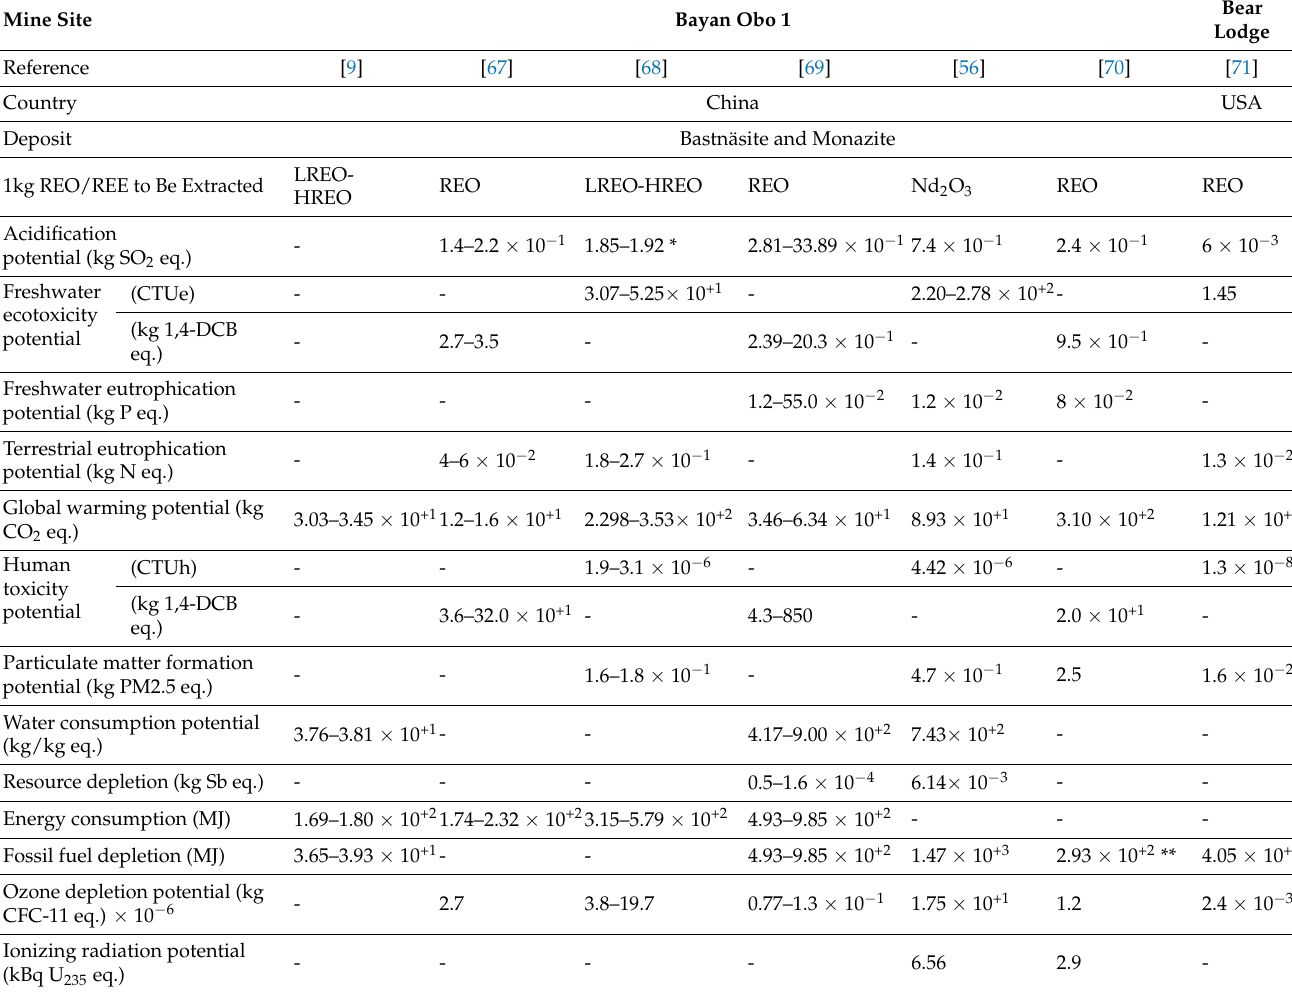
Table A1. LCIA of REE primary production from bastnäsite and monazite